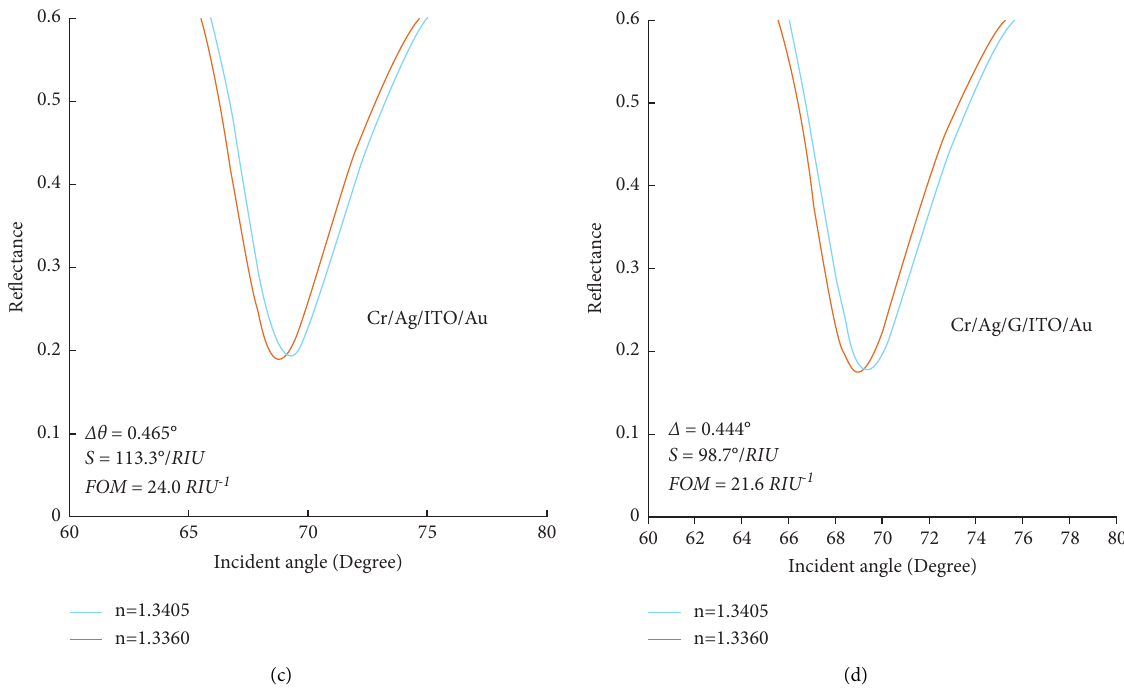
Figure 7: Changes in reflectance in terms of resonance angles, sensitivities, and FOM values. (a) Ag/ITO/Au; (b) Ag/ G /ITO/Au; (c) Cr/Ag/ ITO/Au; and (d) Cr/Ag/ G /ITO/Au. Δ ( n ) � 0.0045. Table 2: The influence of the graphene and Cr layer on sensor sensitivity and FOM value. Sensor configuration